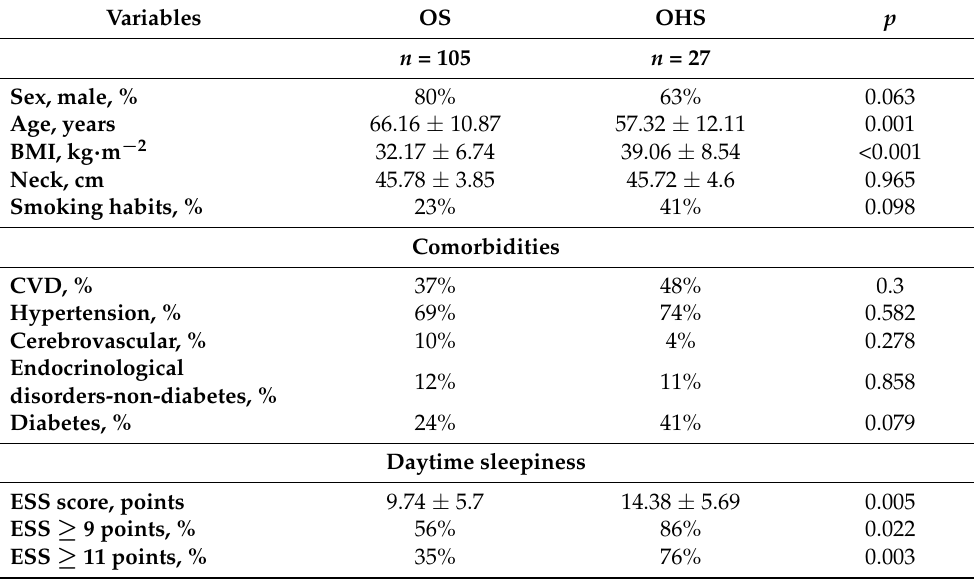
Table 2. Comparison between patients with Overlap Syndrome (OS) and patients with Obesity Hypoventilation Syndrome